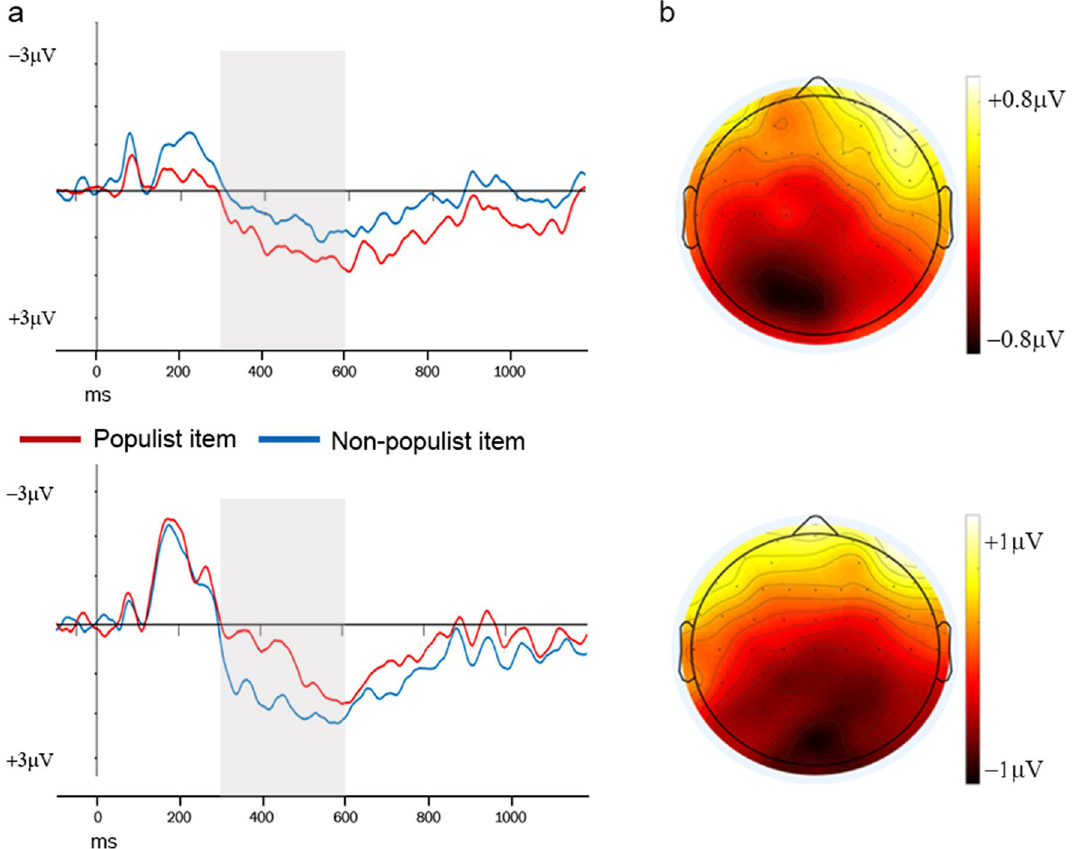
Figure 2. N400 in voters of mainstream and populist parties. ( a ) N400 effects in voters of populist (above) and mainstream (below) parties for economy survey items. All waveforms are from electrode POz, where the effects were most prominent. The grey box illustrates the time window used for statistical analyses. Note that negative is plotted upwards. ( b ) Topographic maps representing the scalp distribution of the observed ERP difference between congruent and incongruent items for economy items in the 300–600 ms latency region in voters of populist (above) and mainstream (below)